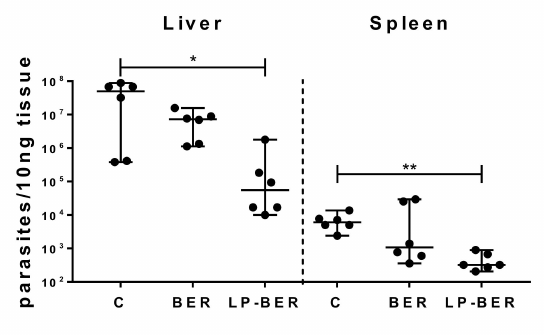
Figure 5. Parasite burden in liver and spleen, measured by qRT-PCR, after 10 consecutive days of i.p. treatment with free BER and LP-BER at 15 mg / kg. Results expressed as median ± 95% IC (n = 6 per group). Data analyzed using a nonparametric Kruskal–Wallis test, followed by Dunn’s multiple comparison. * p < 0.05, ** p <